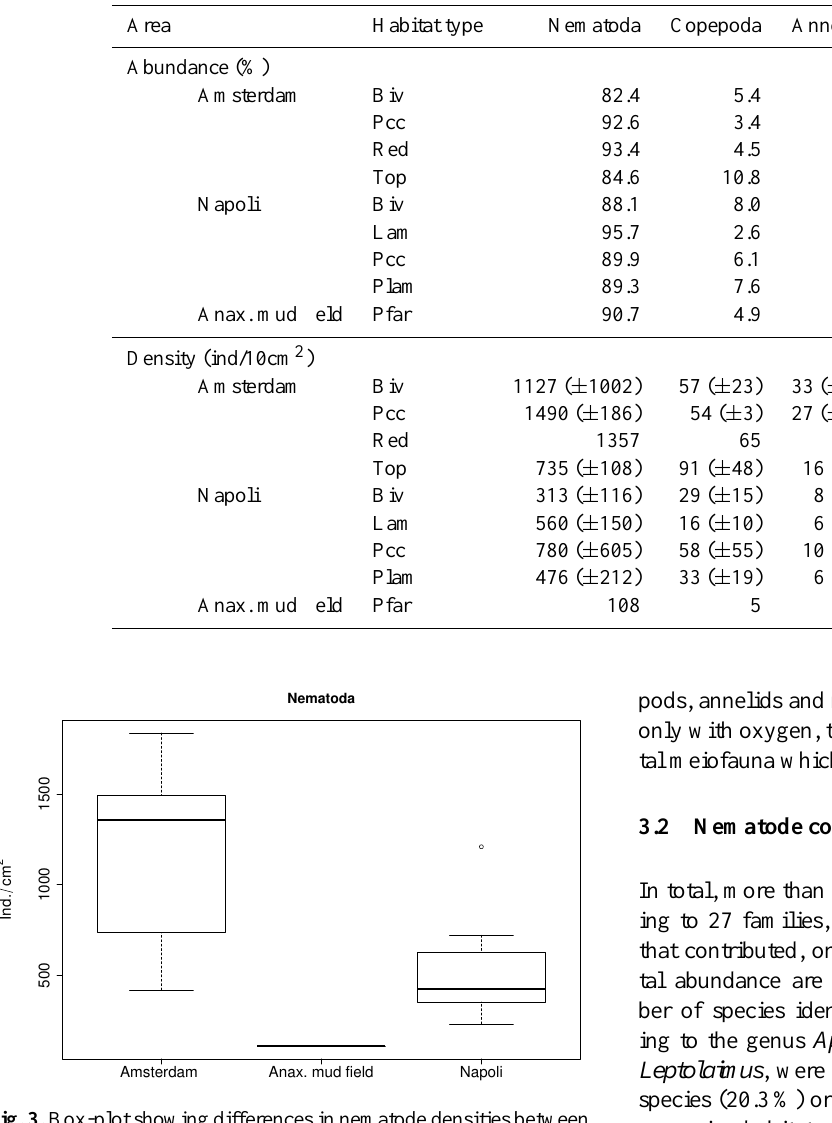
Table 2. Meiofauna relative abundance (%) and density (individuals per 10cm 2 ± SD) at the different microhabitats ( n = 1 for Red and Pfar). For a list of taxa included in “Others” see Table S1 (Biv: bivalve shells; Pcc: periphery of carbonate crusts; Red: reduced sediments; Top: summit of the mud volcano; Lam: Lamellibrachia microhabitat; Plam: periphery of Lamellibrachia ; Pfar: far periphery).